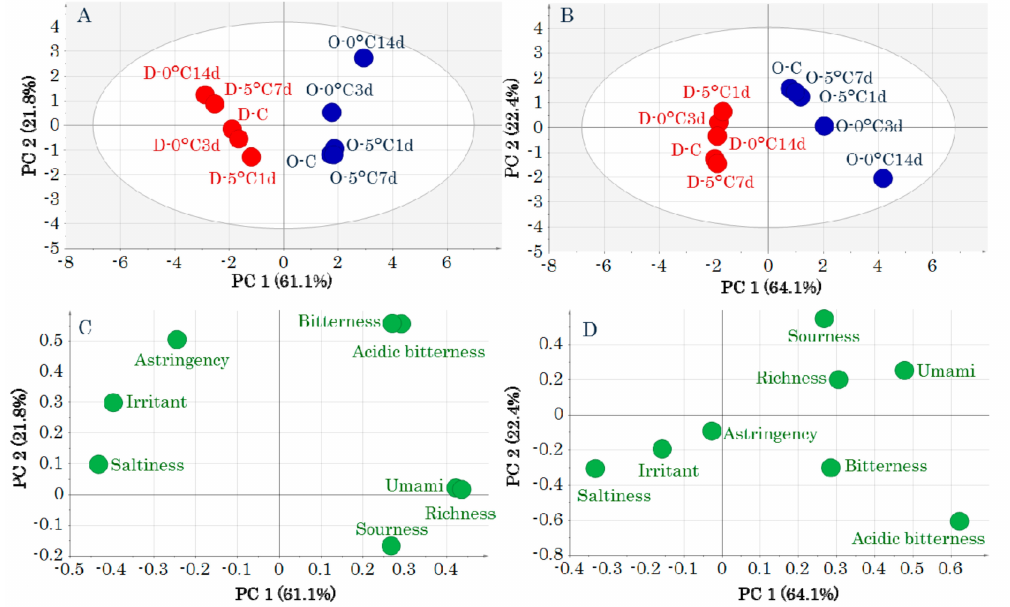
Figure 1. Score plots ( A , B ) and loading plots ( C , D ) obtained by a principal components analysis of taste-attribute profiles. Data were pretreated with unit variance scaling ( A , C ) and pareto scaling ( B , D ). Symbols in score plots ( A , B ) indicate sample IDs (Table S1).